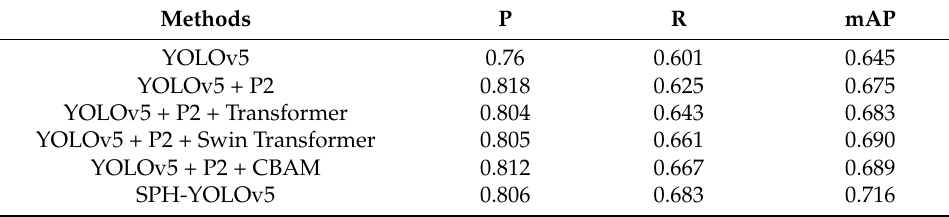
Table 5. The effects of the YOLOv5 combining different modules on the DOTA dataset, where P2 represents the additional feature fusion layers and prediction